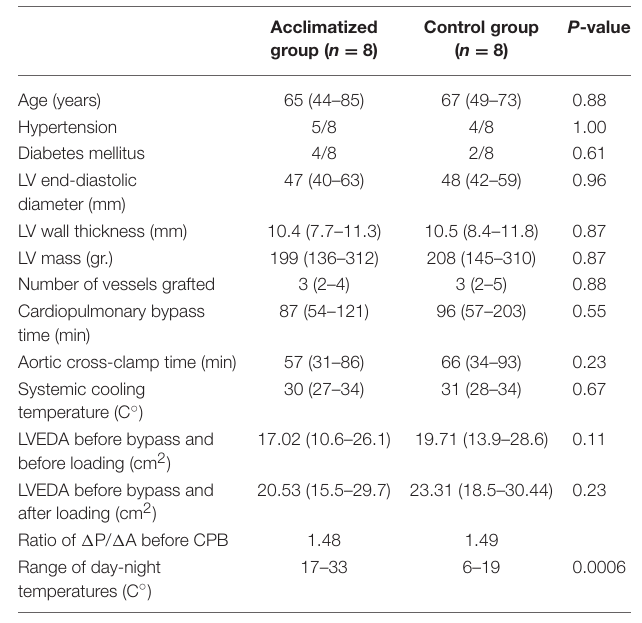
TABLE 1 | Baseline and intraoperative variables in acclimatized and non-acclimatized patients.